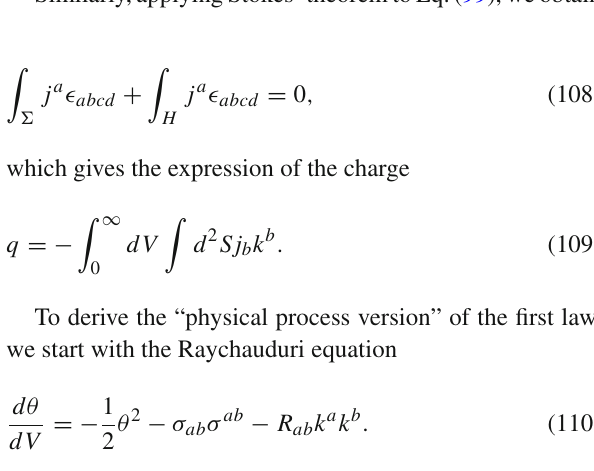
By making use of L ξ A = ξ · d A + d (ξ · A ) = 0 [10], we have ξ b F bc = ξ · d A = − d (ξ · A ) . Then Eq. (97)